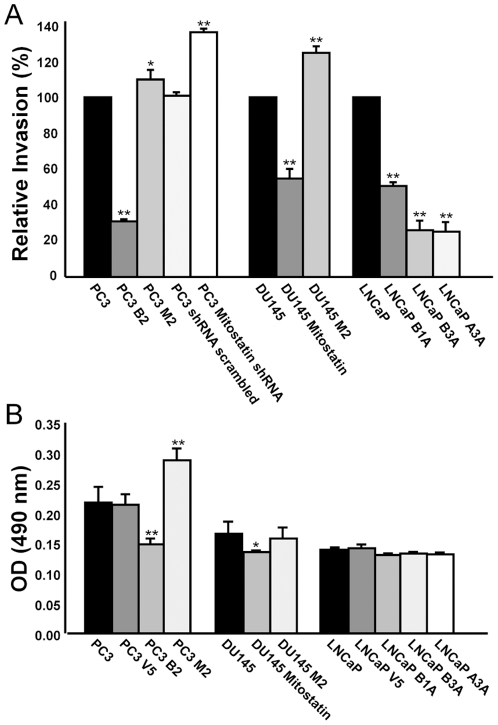
Mitostatin inhibits in vitro invasion and adhesive properties to laminin of prostate cancer cells.
A: Mitostatin inhibits invasive properties of prostate cancer cells. Cells with down-regulation of the endogenous Mitostatin protein (PC3 M2, PC3 Mitostatin shRNA, and DU145 M2) showed an increased malignant behavior. B: Mitostatin over-expression affects cell ability to attach to laminin. Data are expressed as percentage of migration versus parental cells. Columns, representative images of triplicates from three independent experiments; bars, SEM. * P<0.05; ** P<0.01.